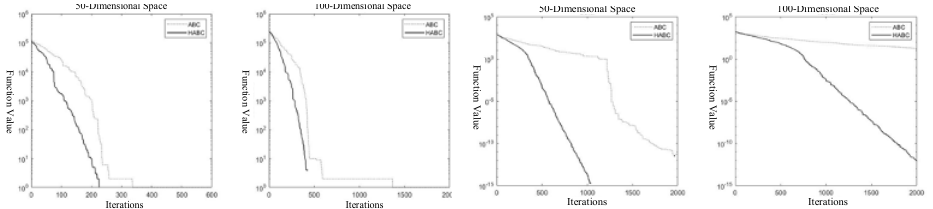
Fig. 4. The convergence curves of Rastrigin in 50- dimensional space and 100-dimensional space.